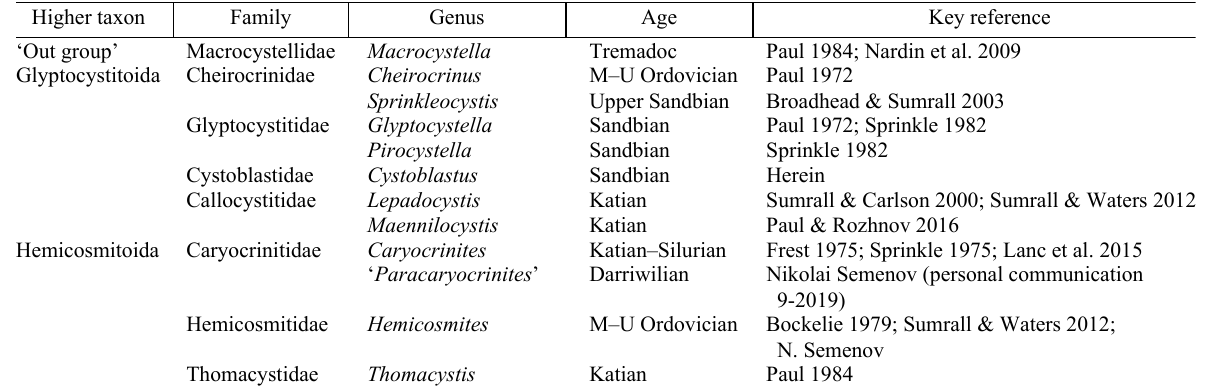
Table 1. Key genera discussed in the text